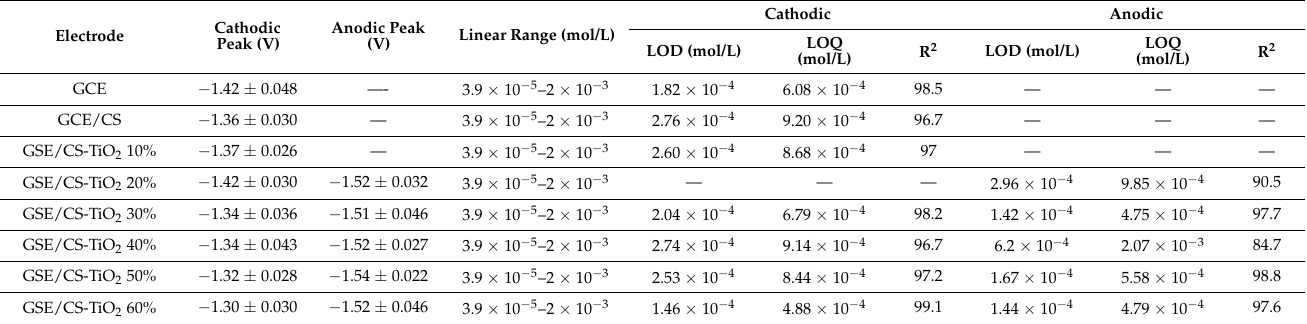
Table 1. Analytical parameters for the determination of IMD on different electrodes.